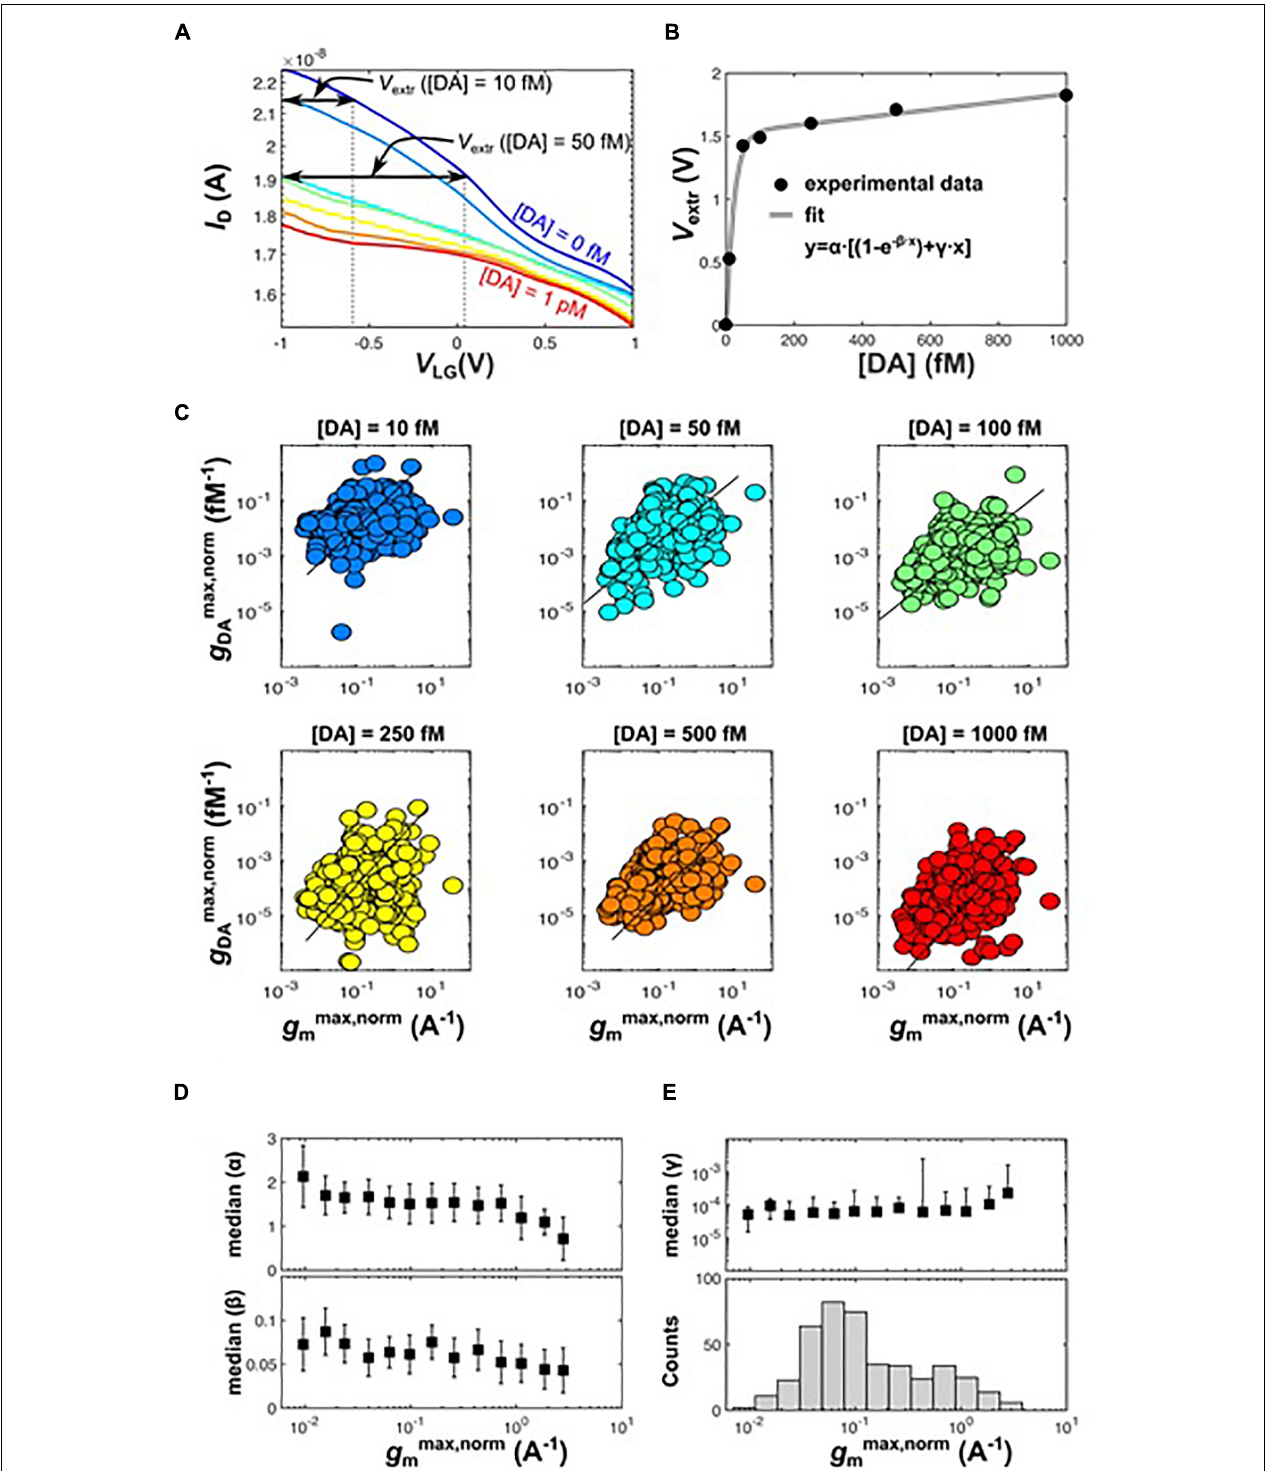
FIGURE 6 | (A) Extraction of dopamine sensitivity (V/fM) from single-device transfer characteristics. The ID ON ([DA]) at V LG = − 1 V was used as reference current level. V extr ([DA]) was the voltage difference necessary to produce a drain current variation in the transfer curve without dopamine. (B) Plot of V extr ([DA]) versus [DA], representing the specific sensitivity to dopamine of the considered device. Such curves can be used for device calibration. The fit to the data is also shown. (C) For several values of dopamine, plots of g DAmax , norm versus g mmax , norm was extracted from the “pristine” transfer characteristics, recorded right after aptamer anchoring at [DA] = 0 fM. (D,E) Median values of the fit parameters α , β and γ versus g mmax , norm . Binning was performed according to the histogram in the bottom panel (E) .